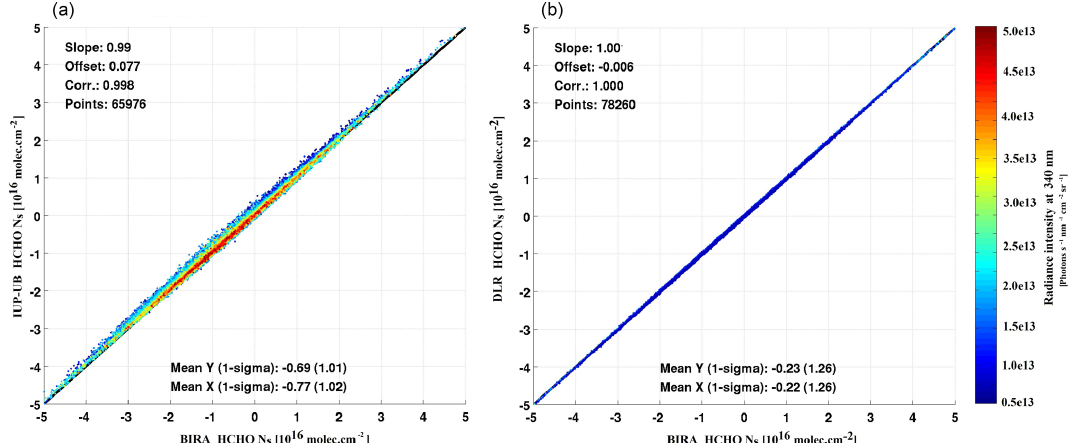
Figure 14. Correlation plots of HCHO slant columns retrieved with the BIRA prototype algorithm and (a) the IUP-UB verification algorithm and (b) the operational processor, for OMI orbit number 2339 on 2 February 2005, including all pixels with SZA<80 ◦ . Table 10. Estimated HCHO vertical column uncertainty budget for monthly averaged low and elevated columns (higher than 1 × 10 16 moleccm − 2 ). Contributions from the three retrieval steps are provided, as well as input parameter contributions. HCHO vertical Remote regions/ Elevated column error uncertainty low columns regions/periods Contribution from systematic slant columns uncertainties 25% 15% Contribution from air mass factors uncertainties 75% 30% From a priori profile errors 60% 20% From model errors 35% 15% From albedo errors 20% 10% From cloud top pressure errors 20% 10% From cloud fraction errors 15% 5% Contribution from background correction uncertainties 40% 10% Total 90% 35% Total without smoothing error 50%